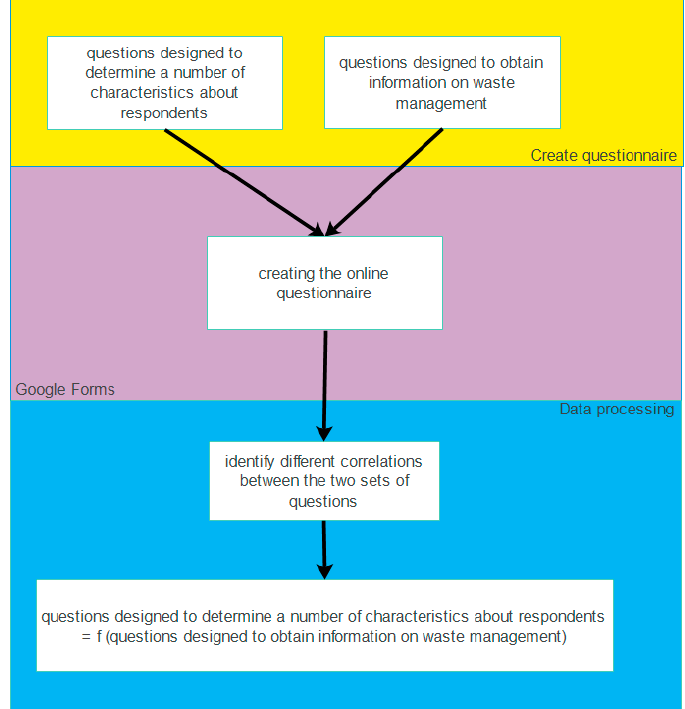
Figure 1. Working methodology.